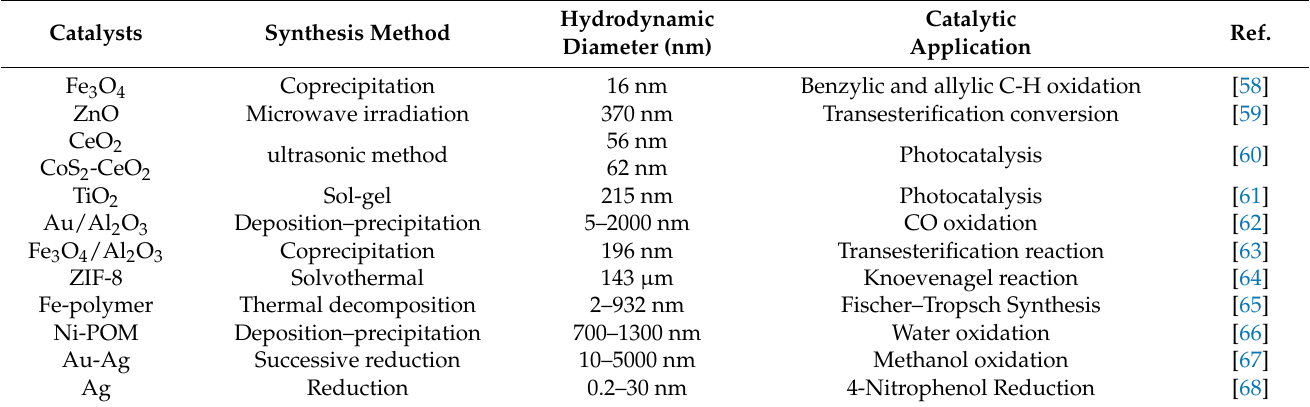
Table 4. Hydrodynamic diameter of different catalysts determined by DLS.